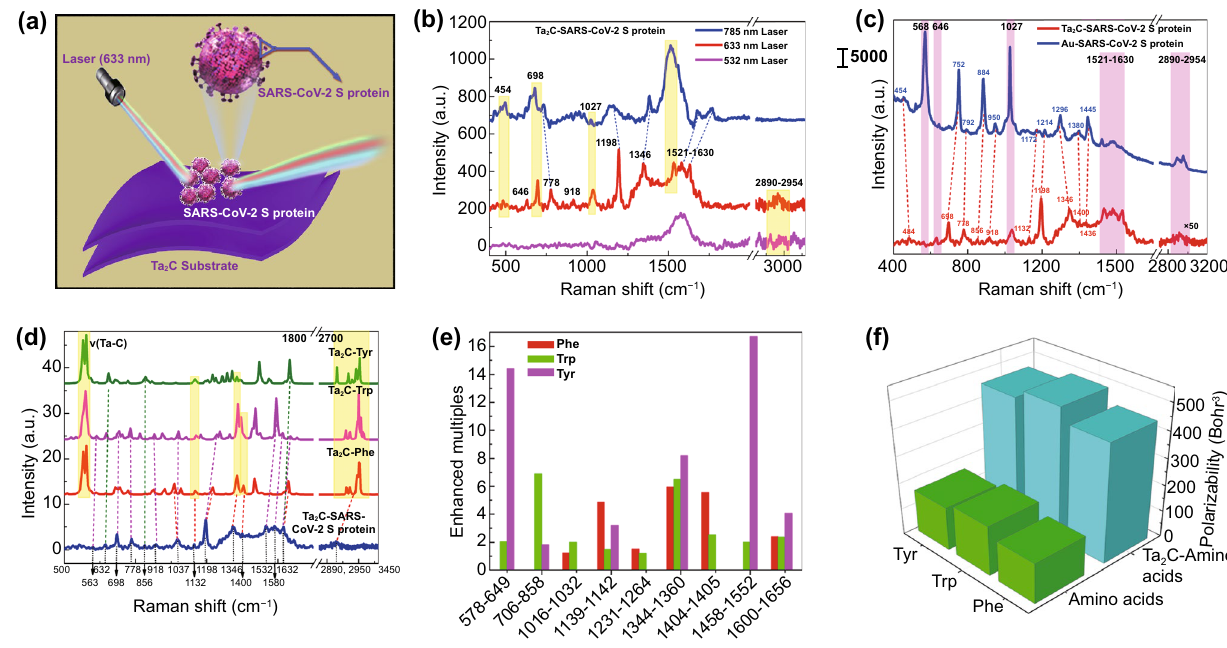
Fig. 6 a Raman schematic diagram of the Ta 2 C NSs for the Raman scattering of SARS-CoV-2 S protein under the excitation laser of 633 nm. b Raman spectra of 10 −9 M SARS-CoV-2 S protein on Ta 2 C NSs substrates under the different laser wavelength excitation of 532 nm, 633 nm, and 785 nm. c Raman spectra of SARS-CoV-2 S protein on Ta 2 C NSs and Au NPS substrates. d Static Raman spectra of amino acid molecules of Phe, Trp, Tyr, and their corresponding Ta 2 C-amino acid molecules complexes, as well as the experimental Raman spectra of SARS-CoV-2 S protein on Ta 2 C NSs. e Raman enhanced multiples of Ta 2 C-amino acid molecules complexes for nine calculated Raman models. f Calculated polarizabilities of amino acid molecules of Phe, Trp, Tyr, and their corresponding Ta 2 C-amino acid molecules